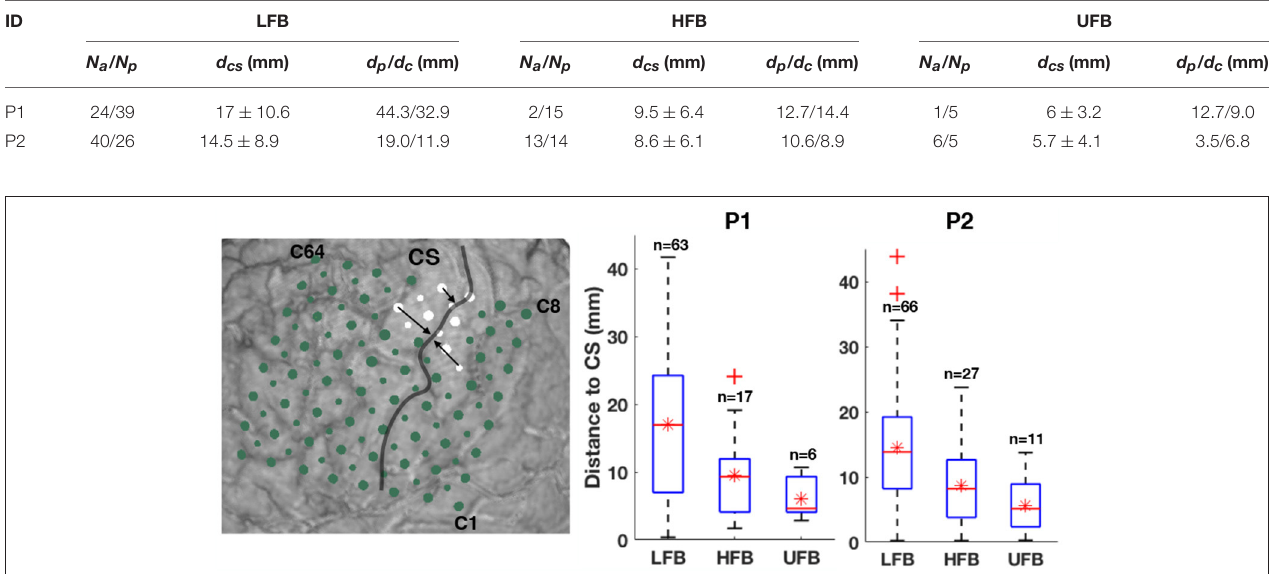
FIGURE 8 | The distances of significant UFB-ERS contacts relative to the central sulcus are partially denoted by black arrows on the MRI 3D rendering of P2 (left). Box and whisker diagram of relative distances to central sulcus (CS) in millimeter within significantly modulated channels in LFB, HFB, and UFB. Sample sizes are shown above the boxes. Red line denotes the median value. Red star denotes the mean value. Outliers of trials are marked as red crosses.